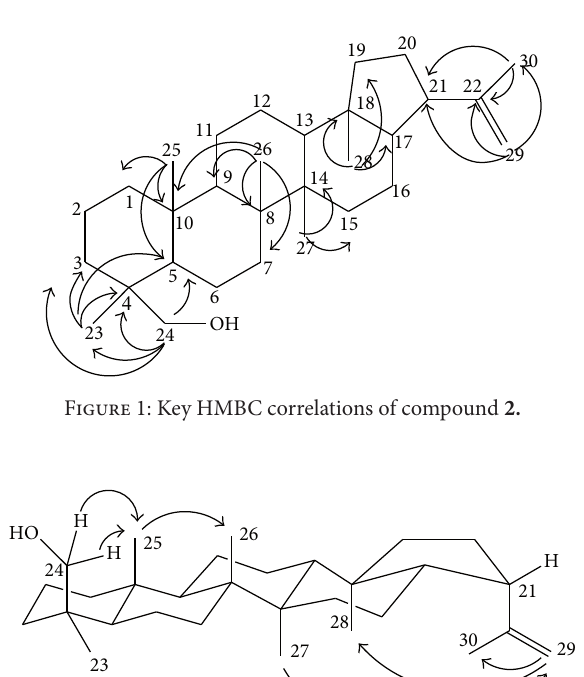
F 2: e key NOE correlations of compound